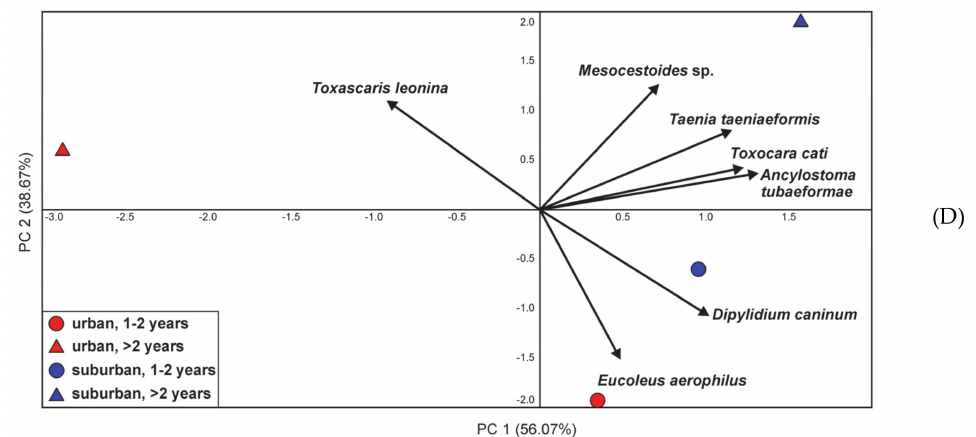
Figure 2. Biplot of the first two axes of the principal component analysis (PCA) of the groups of cats and parasites in relation to ( A ) cats’ sex and age, ( B ) cats sex and season, ( C ) cats sex and habitat and ( D ) habitat and cats age. The percentage of variance explained by the principal components is provided in parentheses.